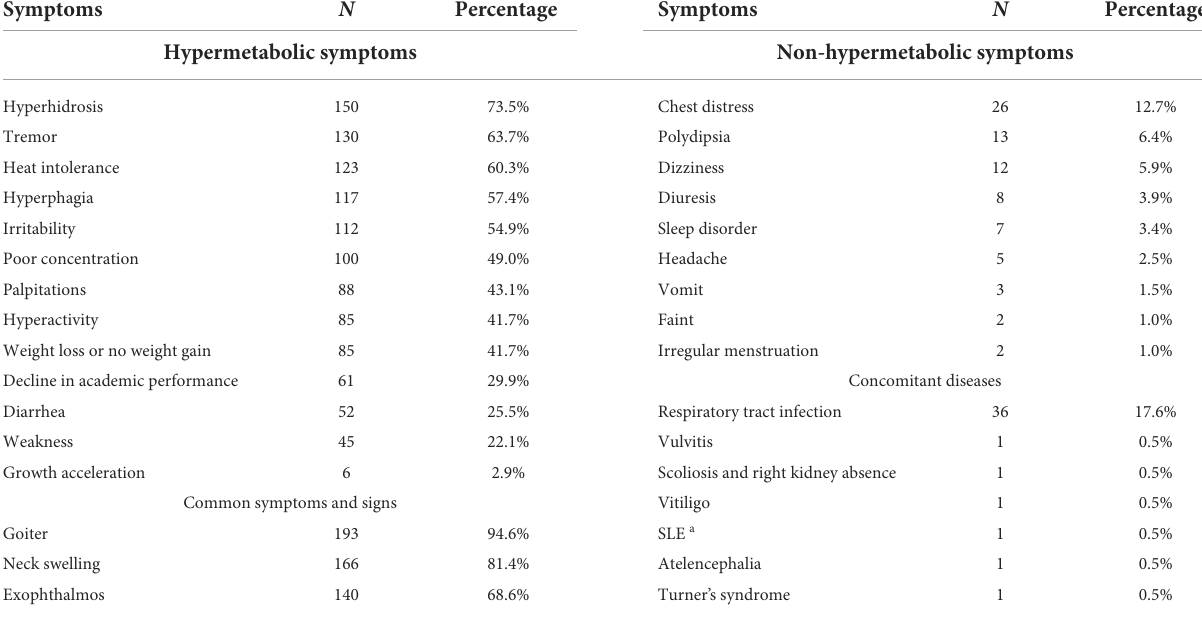
TABLE 1 Retrospective description of symptoms, signs and concomitant diseases after diagnosis of GD.